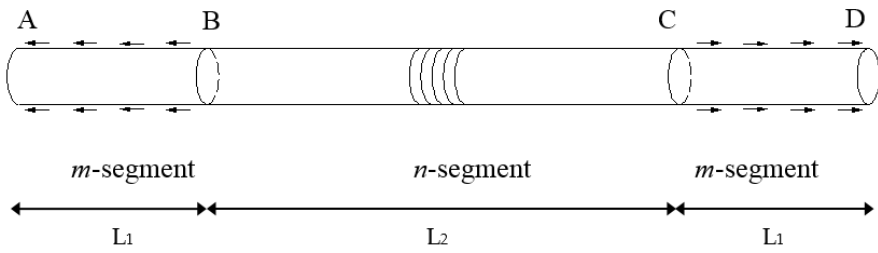
Figure 1. Mechanical model of clamped fiber Bragg grating (FBG).